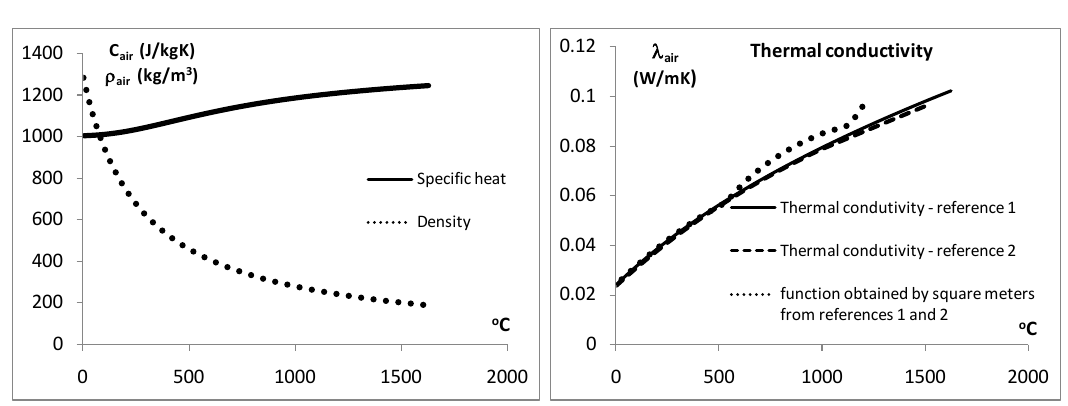
Figure 7. Density, specific heat and thermal conductivity of the